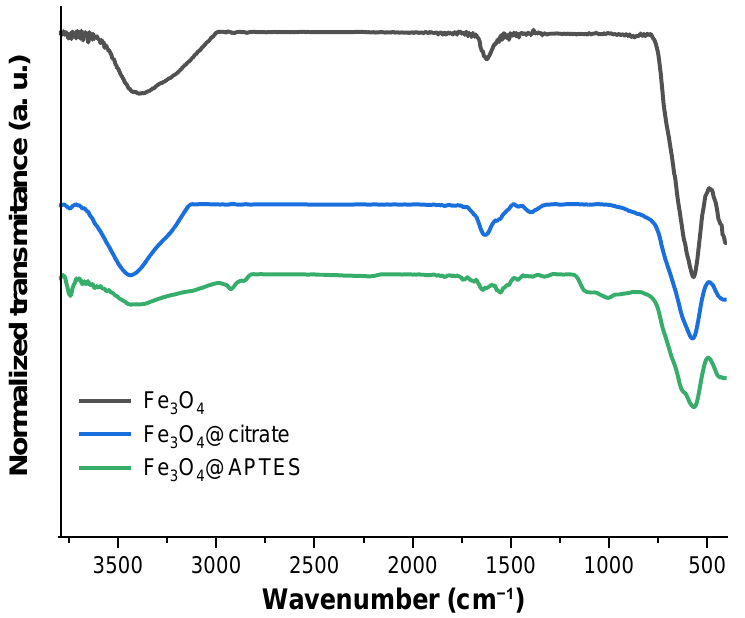
Figure 3. IR spectra of the uncoated magnetite (Fe 3 O 4 ) and magnetite samples coated with sodium citrate (Fe 3 O 4 @citrate) and APTES (Fe 3 O 4 @APTES). Finally, the hydrodynamic diameter of Fe 3 O 4 was determined using dynamic light scattering (DLS) measurements. The value obtained (180 ± 70 nm) was used as a reference for comparison to the coated magnetite